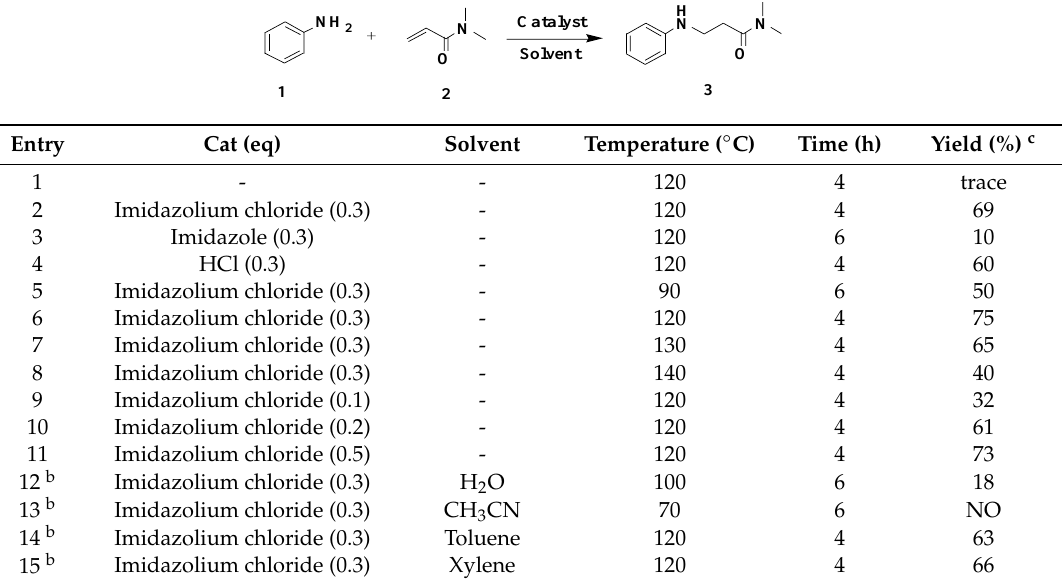
Table 1. Optimization of conditions for the reaction of the Aza-Michael addition.